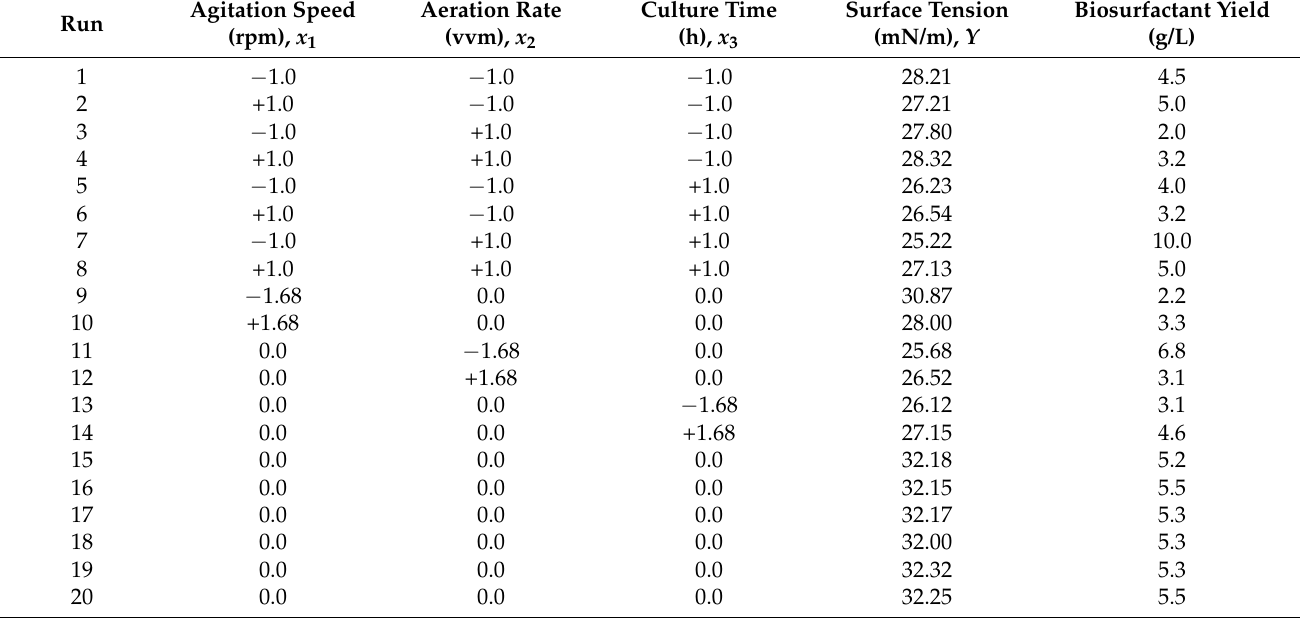
Table 2. Central composite rotatable design matrix used to optimize biosurfactant production by Candida sphaerica (UCP 0995), and experimental results of surface tension (response) and biosurfactant